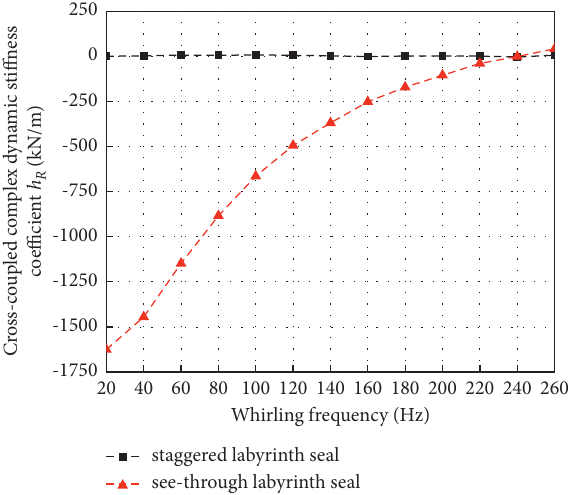
Figure 29: Cross-coupled complex dynamic stiffness coefficient vs. whirling